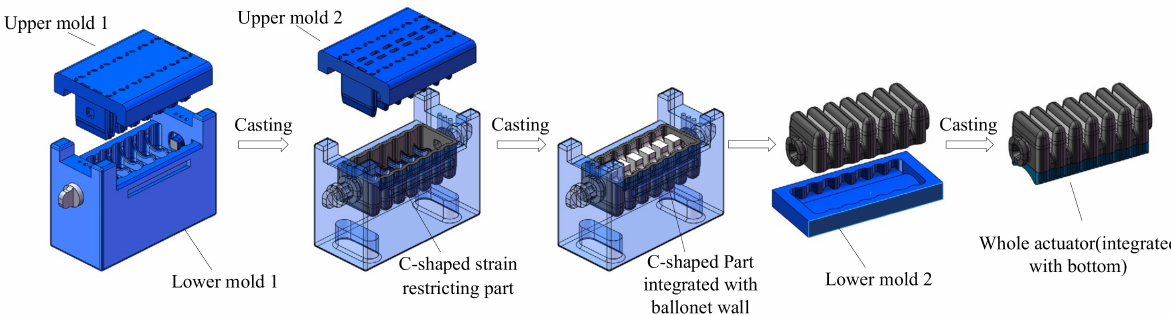
Figure 6. Fabrication of the actuator.